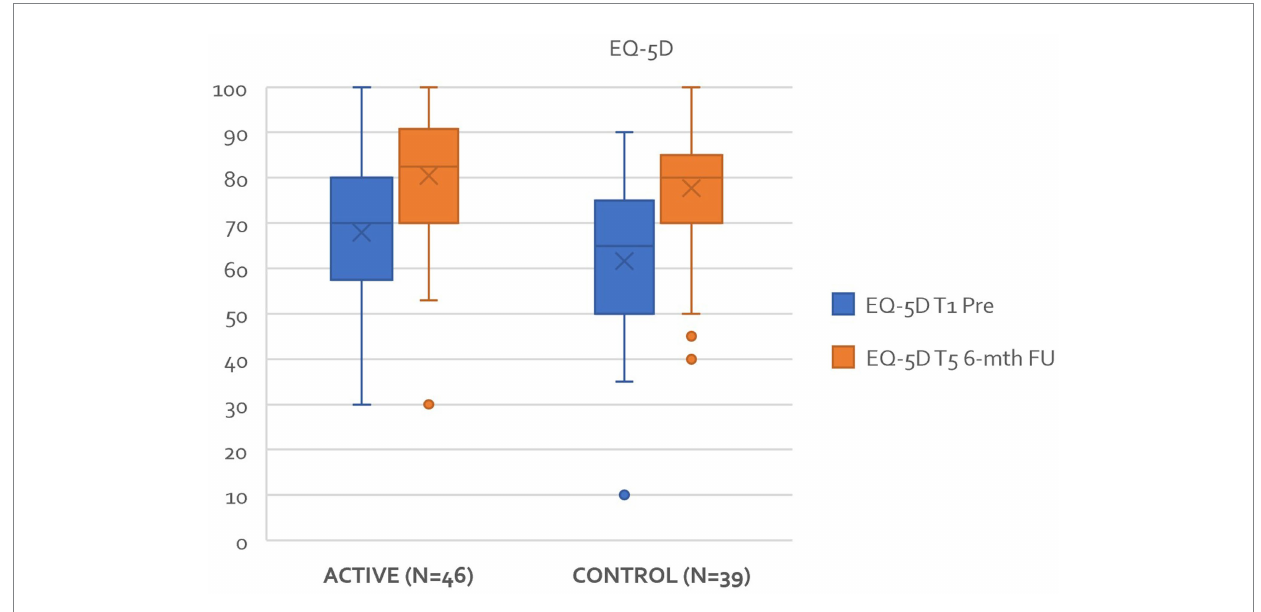
FIGURE 9 Improvements in EQ-5D between T1 and T5 active and control groups.